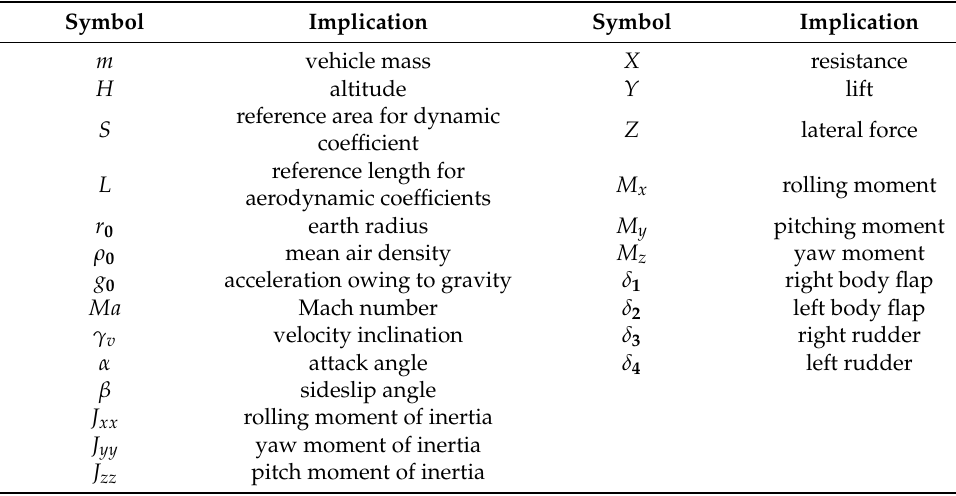
Table 1. Parameter Implication of the HSV